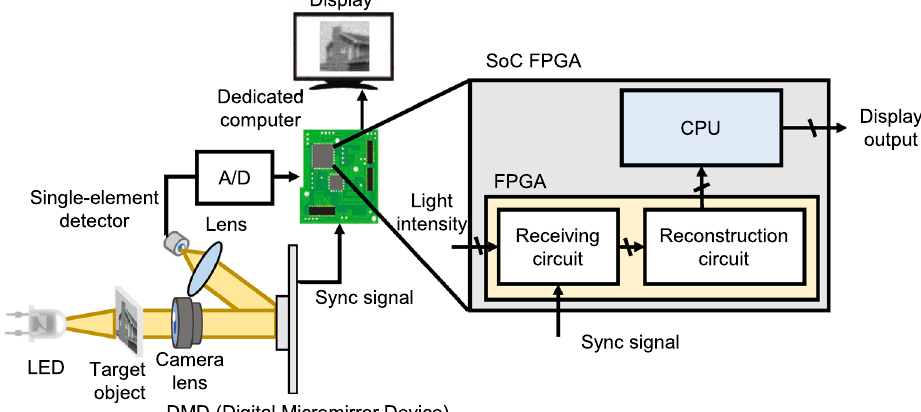
Figure 1. Schematic of the experimental setup. A camera lens forms the image of a target object on a DMD. The image of the target object is modulated by encoding mask patterns displayed on the DMD. The modulated lights are collected by a lens and measured by a single-element detector, and subsequently converted to digital signals. Furthermore, the dedicated computer reconstructs the image of the target object from the light intensities. The FPGA part reconstructs an image, whereas the embedded CPU on the SoC FPGA generates the drawing on a display and